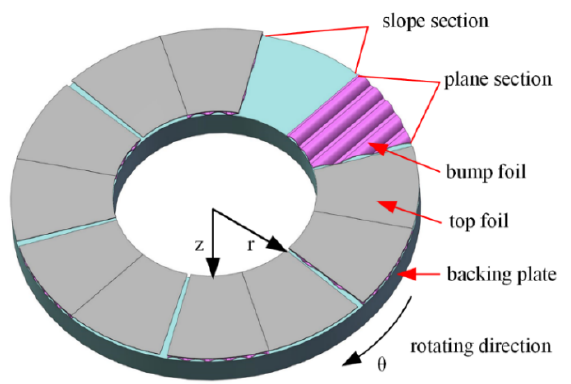
Figure 1. Structure of thrust bump foil gas bearing.